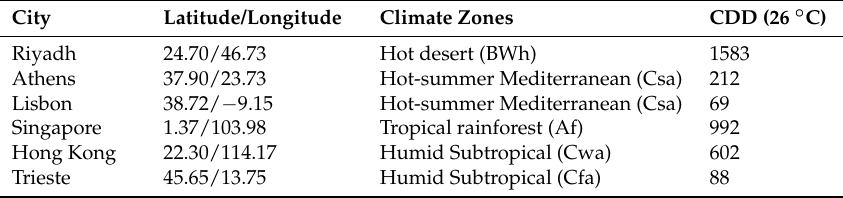
Table 1. Cities selected for the assessment, representing several warm climate zones.